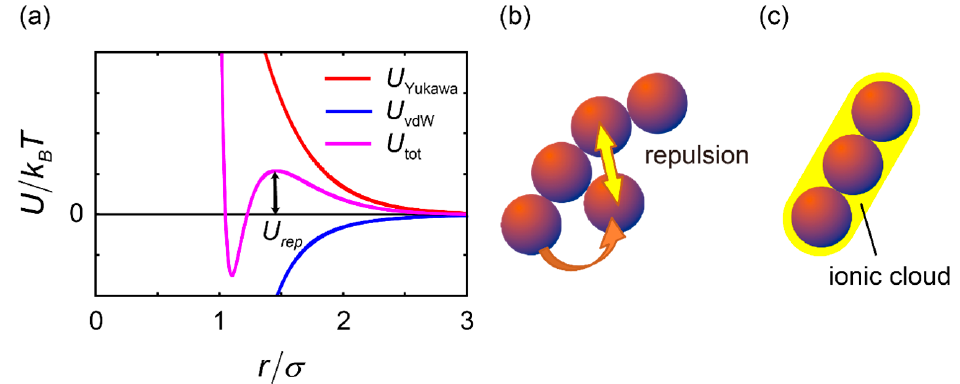
Figure 4. Chain-like cluster formation. ( a ) Schematic explanation of an effective potential acting on cells. The blue and red lines show the electrostatic repulsion and integrated van der Waals attractions, respectively; ( b ) The long-range nature of repulsive Coulomb interactions stabilized the chain by preventing the clusters from folding; ( c ) Ionic clouds surrounding cells may also play an important role in making the chain-like structure rigid.